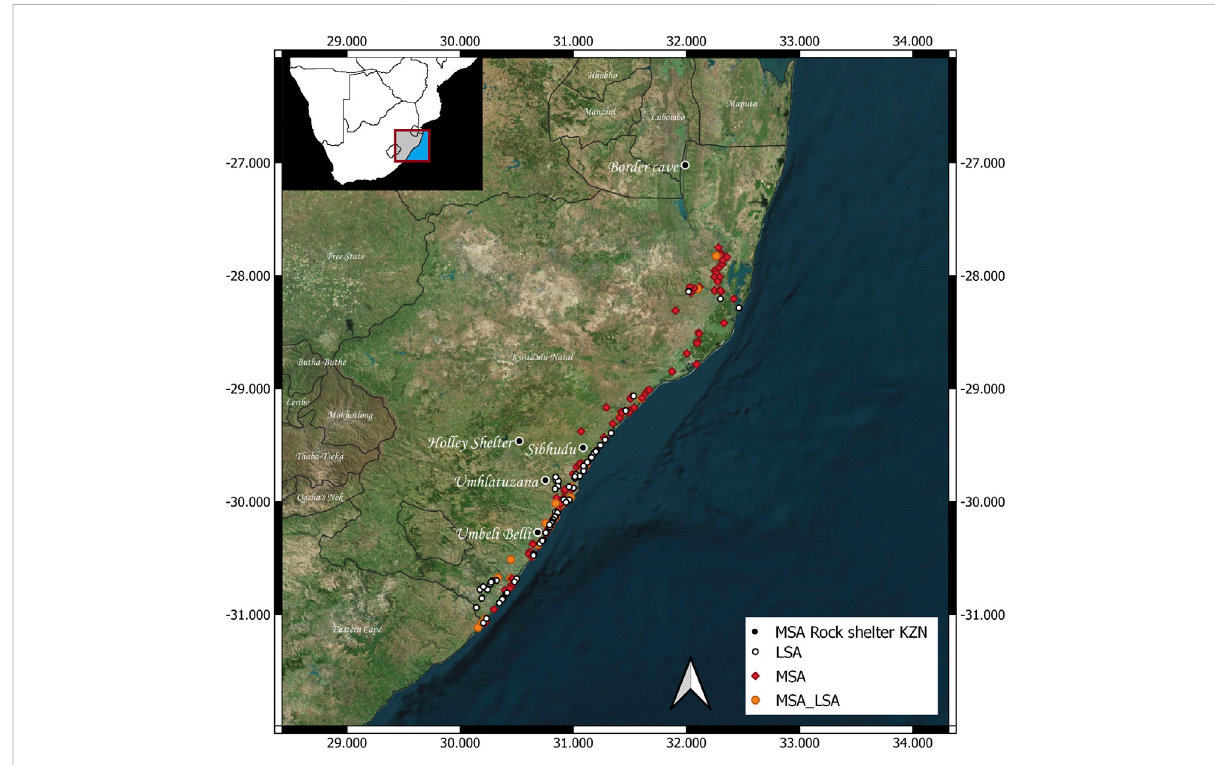
FIGURE 1 Overview map of theprovince ofKwaZulu-Natal insouthern Africa (see inset top left) with named keyMSA rockshelter sitesas well as MSA, LSA and mixed MSA/LSA sites from an exhaustive database of sites within a transect of 20 km from the modern